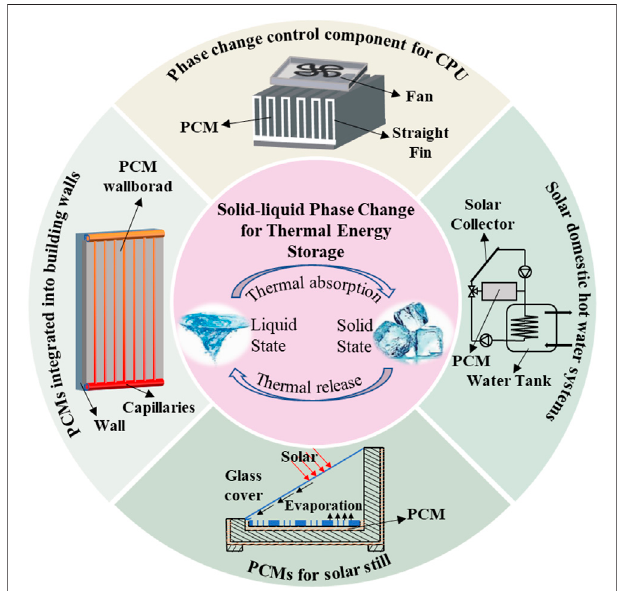
FIGURE 1 | Applications of the